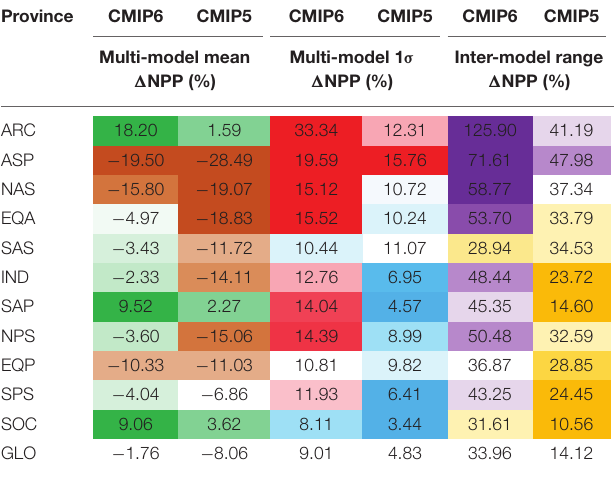
TABLE 2 | Statistics (as percentage changes) for the multi-model mean, 1 σ “likely” range and the full inter-model range across different regions and globally for 16 CMIP6 and 10 CMIP5